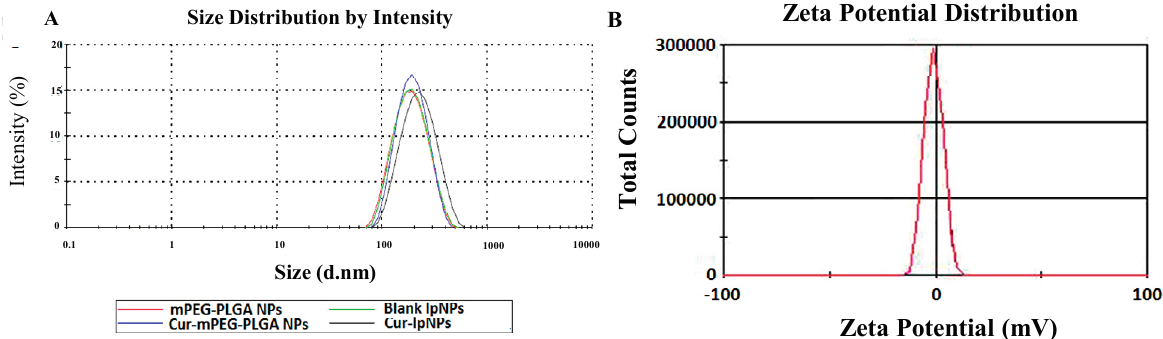
Figure 1. Characterization of Cur–lpNPs. ( A ) particle size of Cur–lpNPs; ( B ) zeta potential of Cur–lpNPs. Size Distribution by